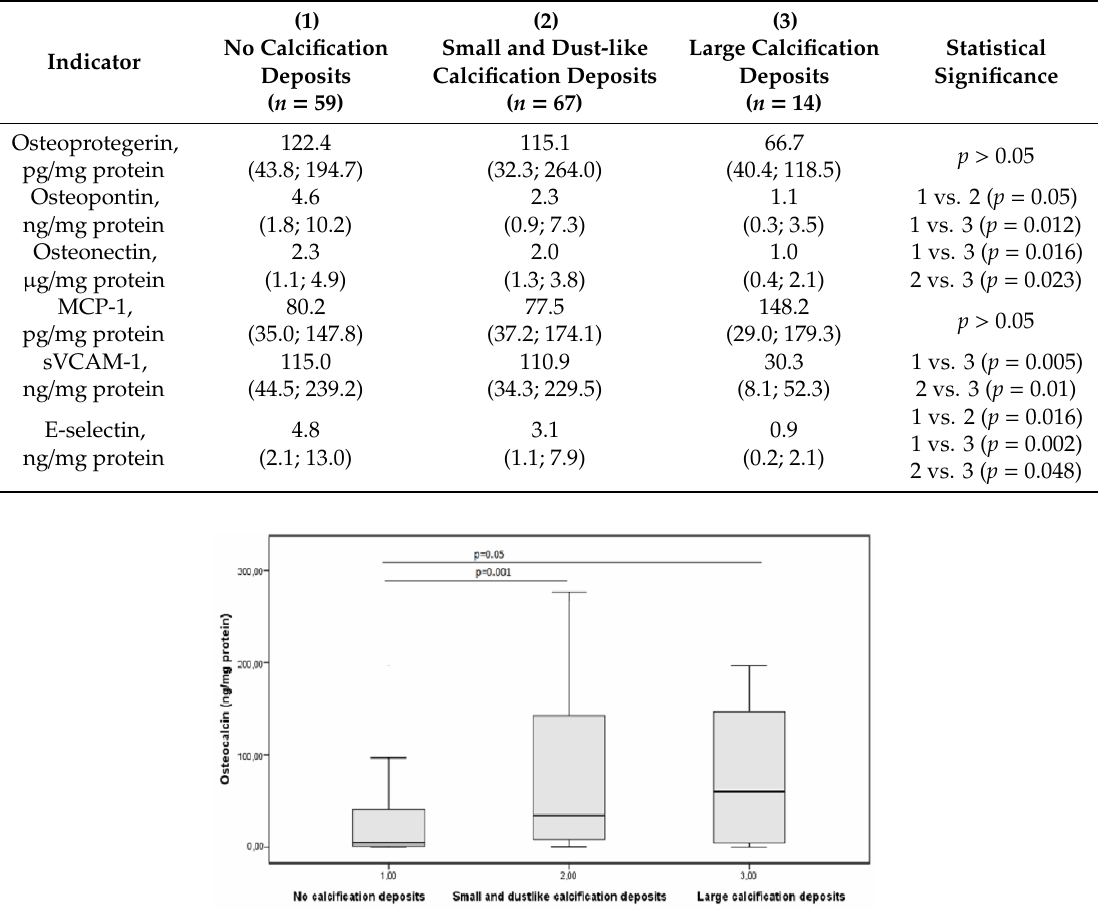
Figure 3. Changes in the concentration of osteocalcin with an increase in the degree of calcification of atherosclerotic plaque.